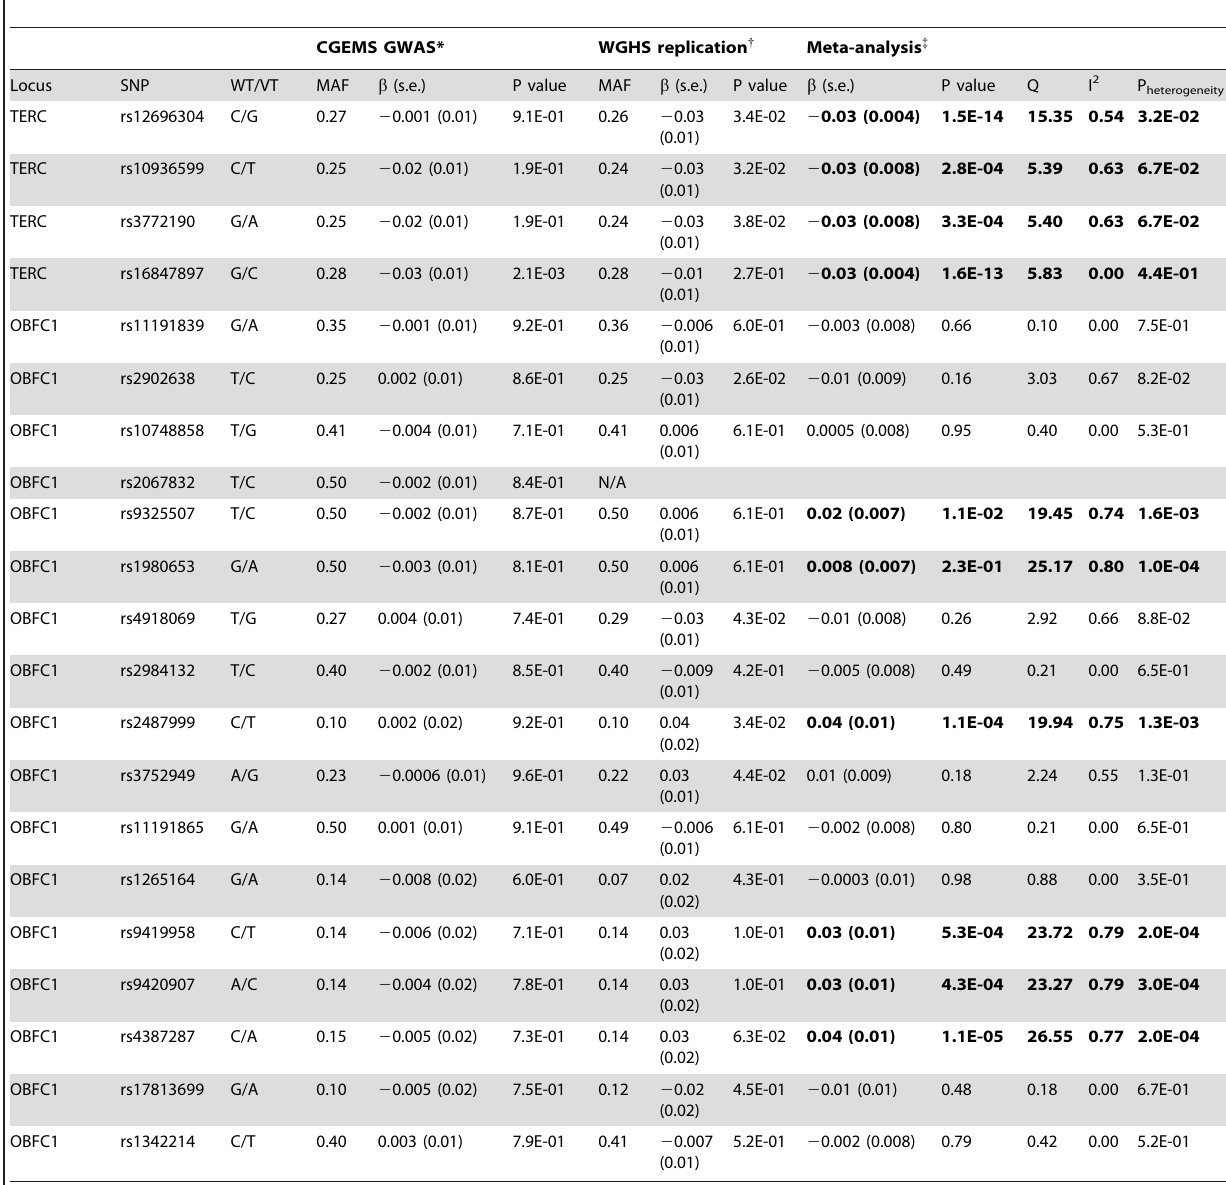
Table 2. Relative telomere length associations with SNPs at loci identified by published GWAS.